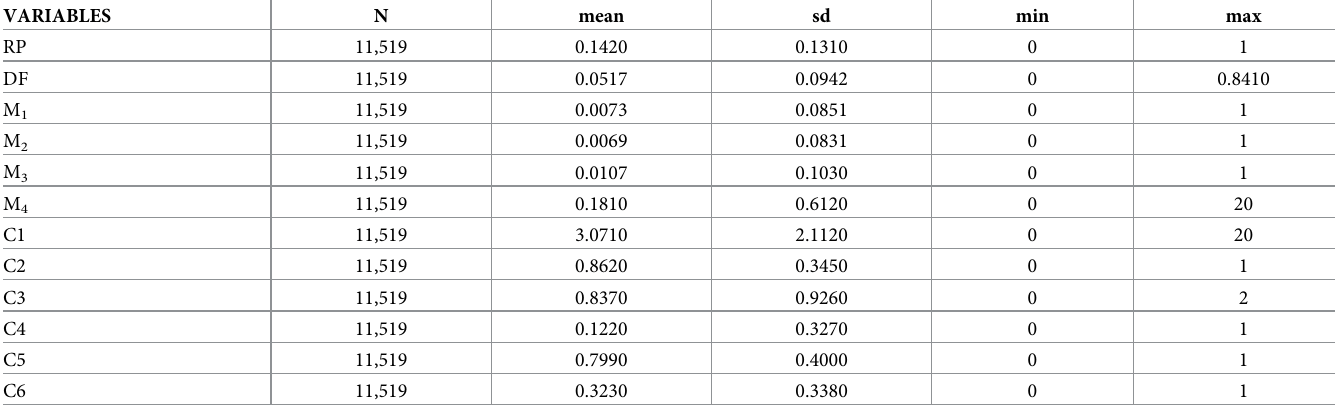
Table 4. Descriptive statistics of